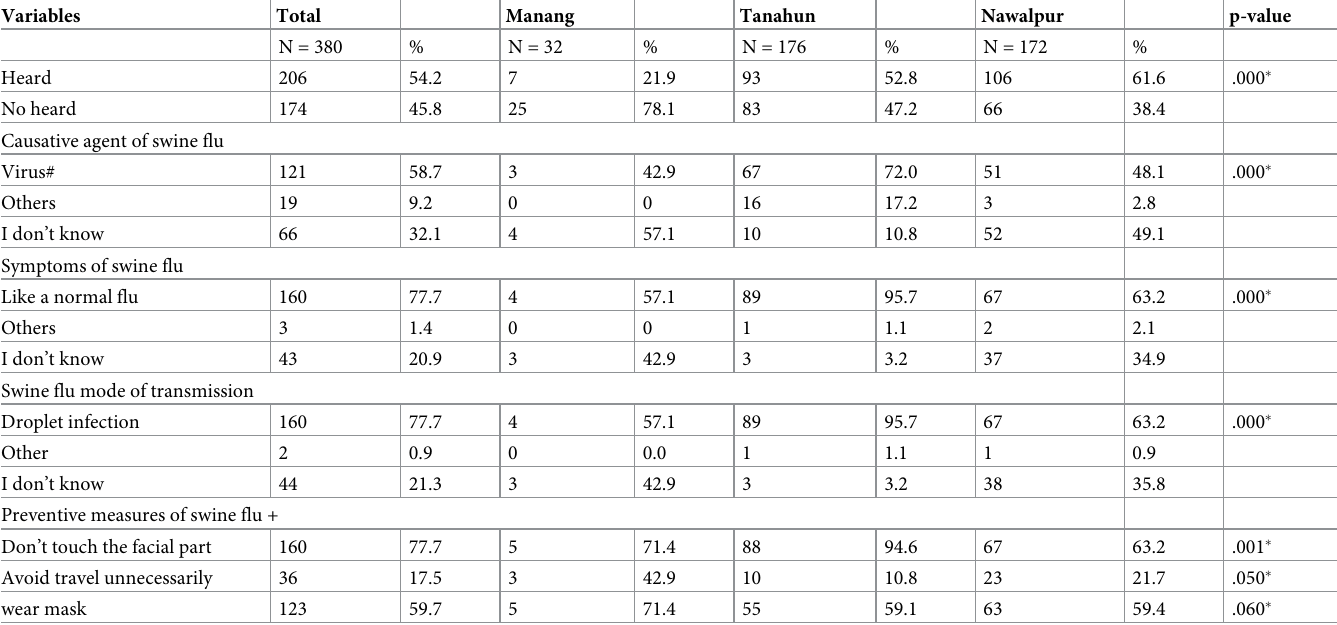
Table 4. Swine flu; knowledge based on ecological regions of the